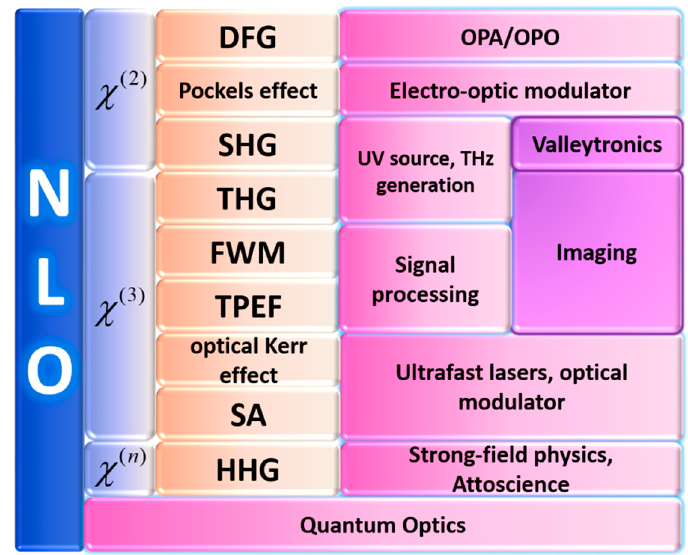
Figure 1. Typical nonlinear optical applications. Light blue, orange, pink and purple gradients represent different order nonlinear optics (NLO) susceptibility, nonlinear processes corresponding to different NLO susceptibility, application, and further applications respectively.